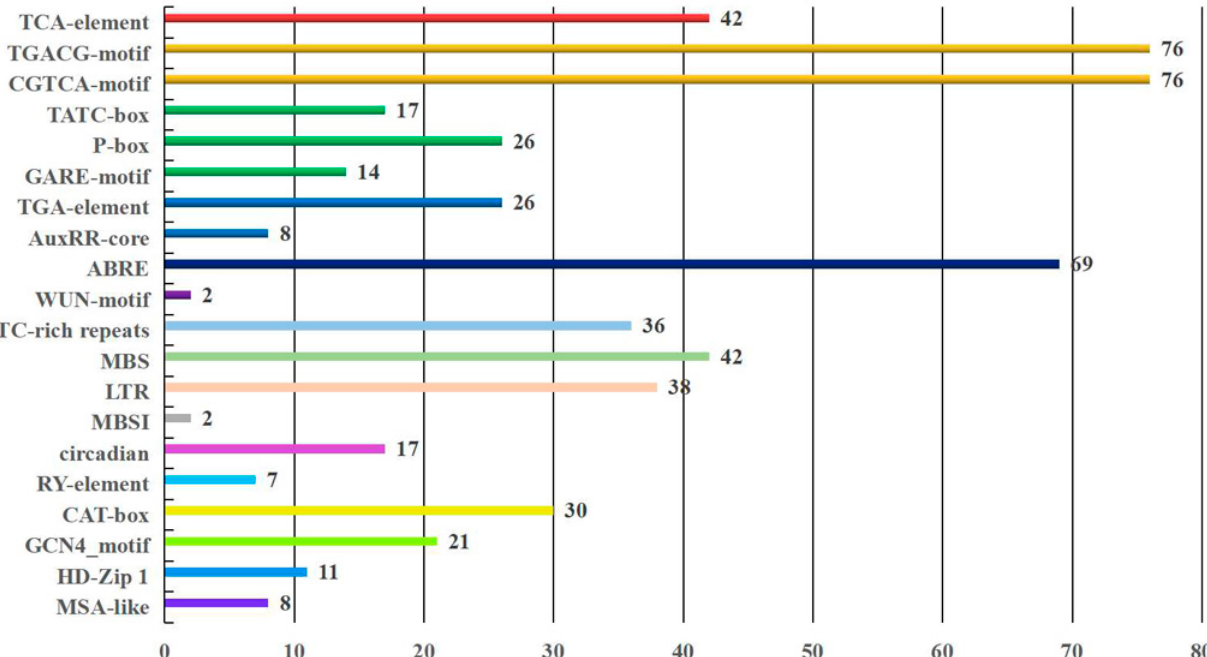
Figure 4. The number of DcNAC promoters containing various cis -acting elements. Different colors represent different cis -element types. The numbers above the columns represent the number of promoters.